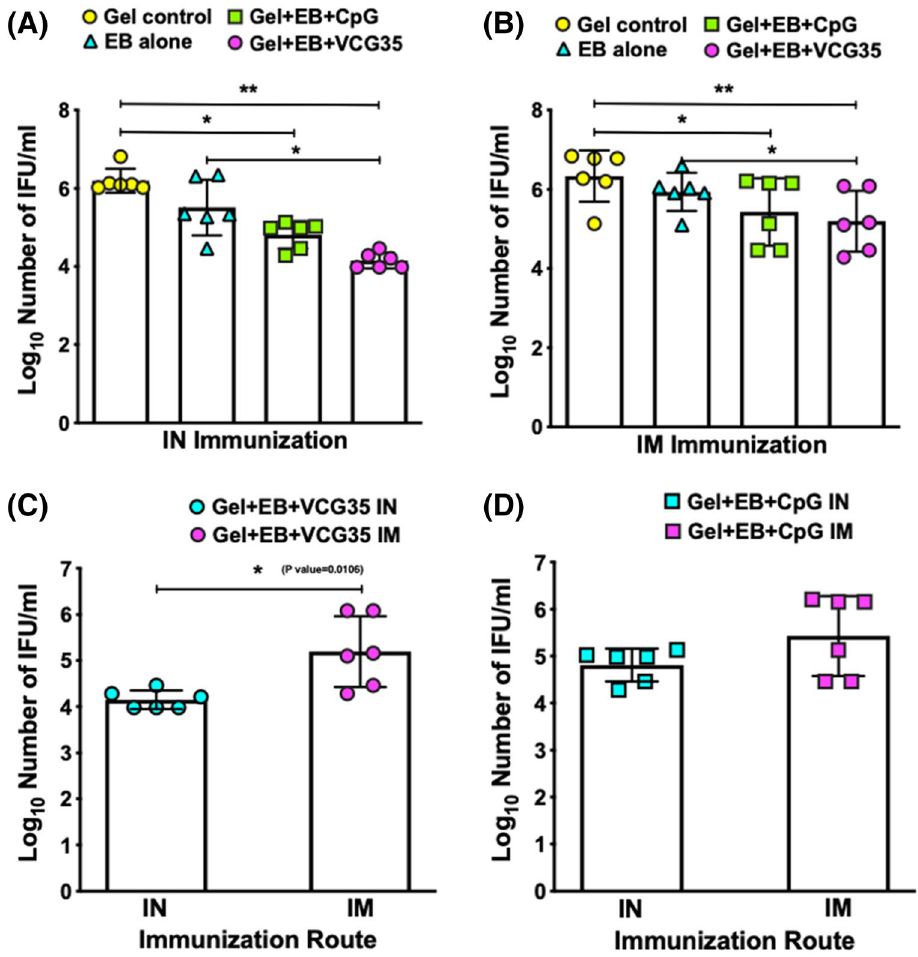
Figure 4. Pharyngeal chlamydial burden in immunized chickens challenged with C. psittaci . Groups of chickens were immunized IN ( A ) or IM ( B ) as described above and challenged intranasally with 1 × 10 8 IFU of live C. psittaci 2 weeks after the booster immunization. To monitor bacterial burden, pharyngeal swabs were obtained from individual chickens (6/group) 2 weeks post challenge and C. psittaci was isolated from swabs in tissue culture. Chlamydial inclusions were detected by fluorescence microscopy using the Imagen immunofluorescence kit (Oxoid, UK) and enumerated. The data show the number of recoverable IFUs expressed as log 10 IFU/ml. Comparison of the number of recoverable IFUs shed by Gel + EB + VCG35 ( C ) and Gel + EB + CpG (D) following IN and IM administration is also shown. Differences between experimental groups within each administration route were compared by One-way ANOVA with Tukey’s post multiple comparison test while differences in number of recoverable IFUs between IN and IM administration were compared by 2-tailed t-test at p * < 0.05 and p ** <